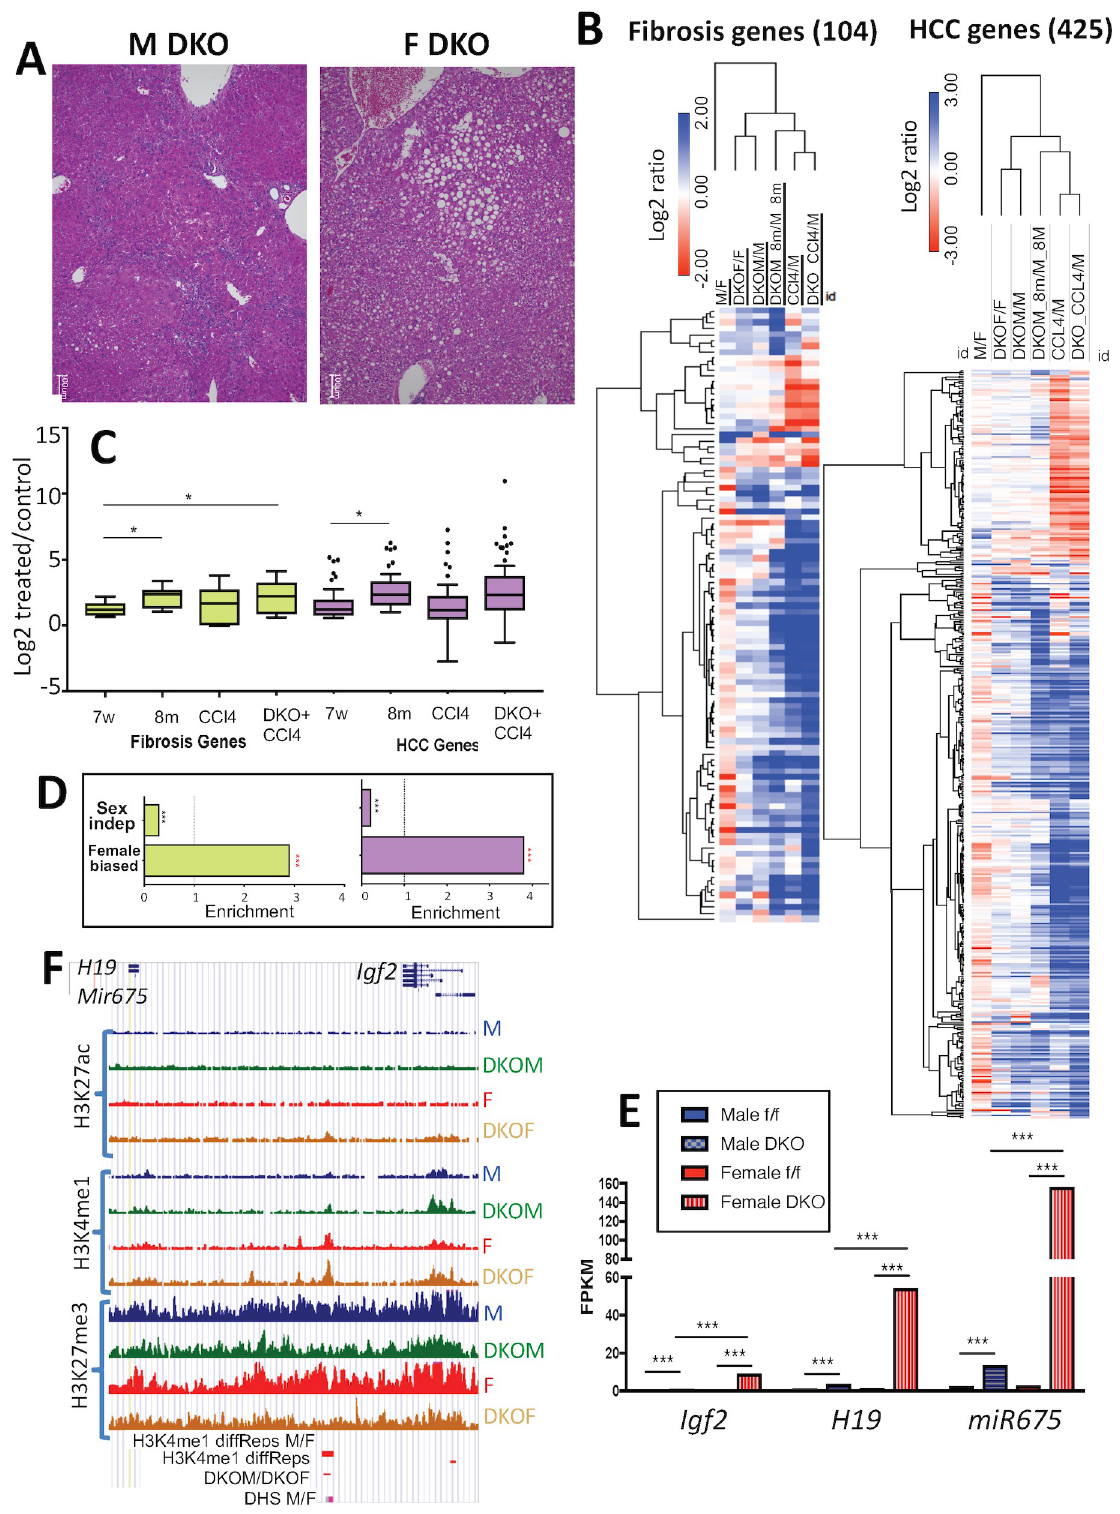
Fig 7. Sex-biased dysregulation of liver fibrosis and HCC related genes. (A) Hematoxylin and eosin staining of 8-month old male and female mouse E1/E2-KO liver sections, showing distortion of the lobular structure in both sexes. The male E1/E2-KO liver has a nodular appearance and inflammatory cell infiltration, while the female E1/E2-KO liver shows micro and macro vesicular steatosis. ( B ) Heat maps